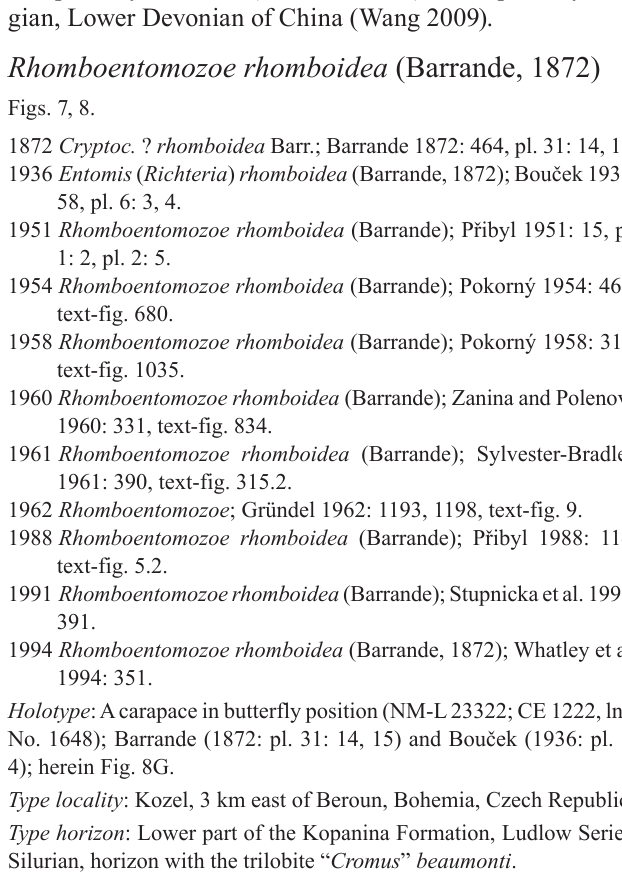
Silurian, horizon with the trilobite “ Cromus ” beaumonti .